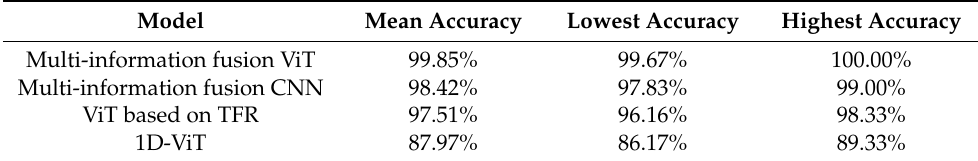
Table 4. Test results for the bearing dataset produced by the diagnostic models. Model Mean Accuracy